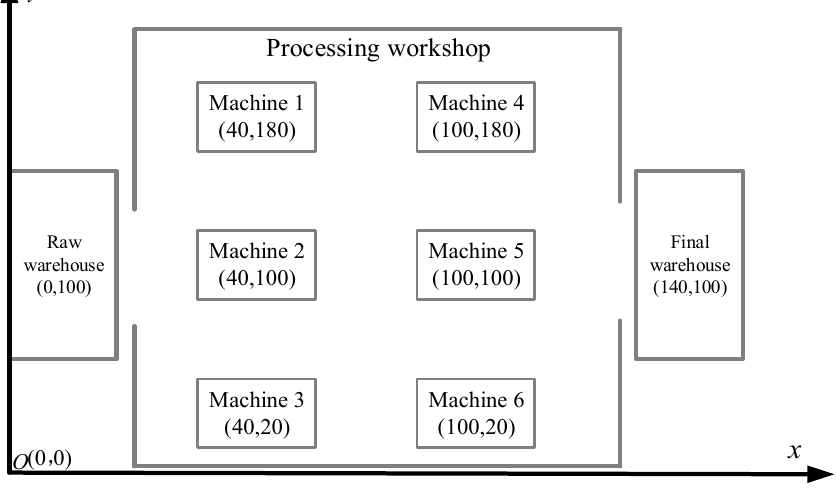
Figure 6. The two-dimensional graph of the working layout of the workshop.